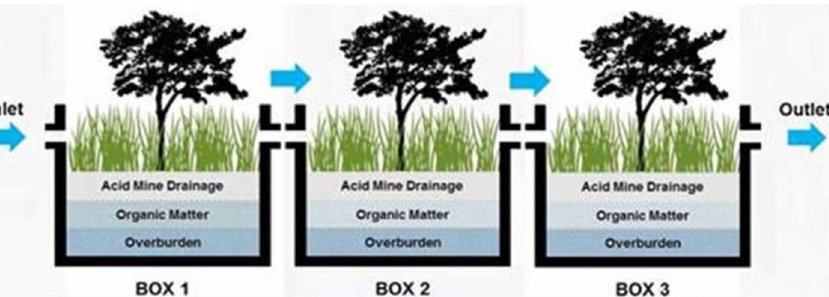
Figure 3. The AMD flows into the inlet, then box-1 discharges into box-2, then into box-3 and the outlet. The pH was monitored in each box from day 1 until day 5 and other threshold parameters were monitored at the inlet and the outlet on day 5, 10, 15, 30 only.